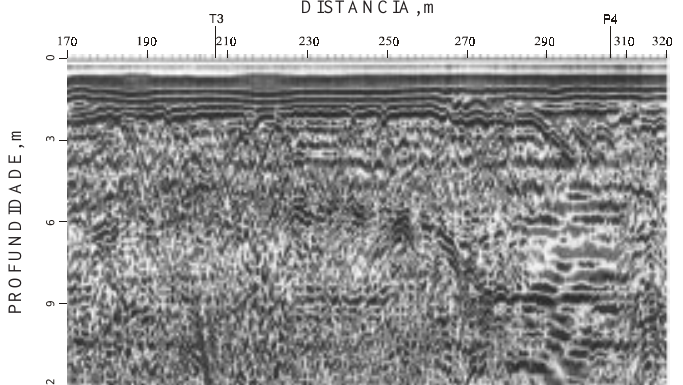
Figura 3. Radargrama - R3 mostrando Espodossolo com duripã entre as distâncias de 170-285 m e Espodossolo sem presença de pã entre 285-310 m. Perfil P4 localizado em 306 m. Tradagem T3 localizada em 207 m.